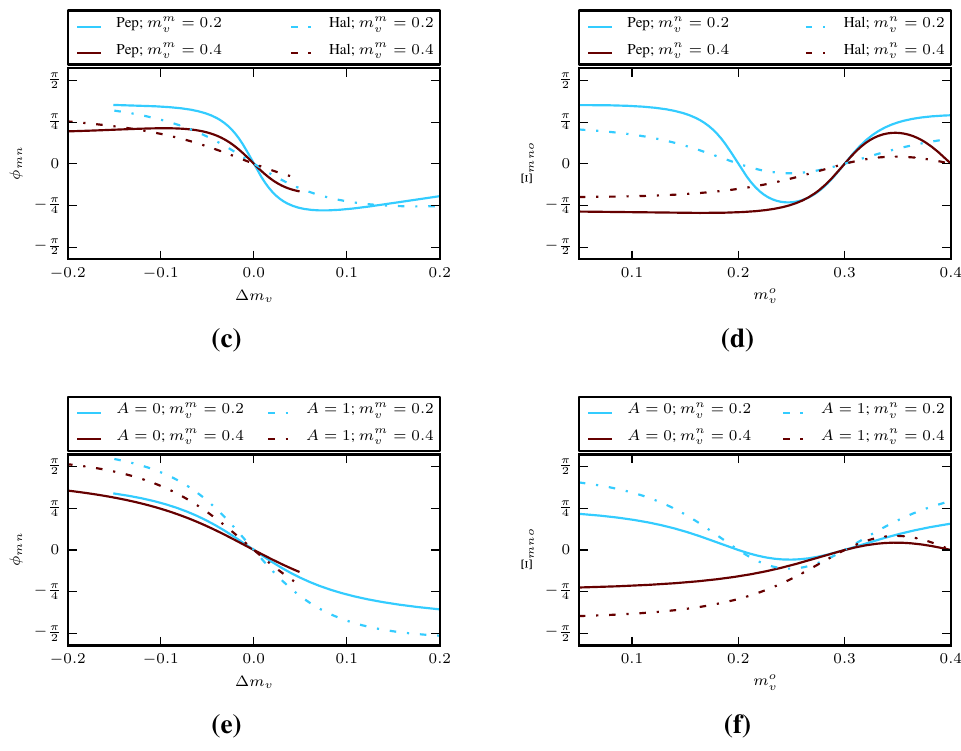
Figure 3. Model predictions for different observables (HH polarization) using the Peplinski mixing model Pep [16] or the Hallikainen [15] model Hal. In panel a) the volume-to-ground ratio f varies, in the remaining ones the soil moisture varies. ( a ) Coherence values